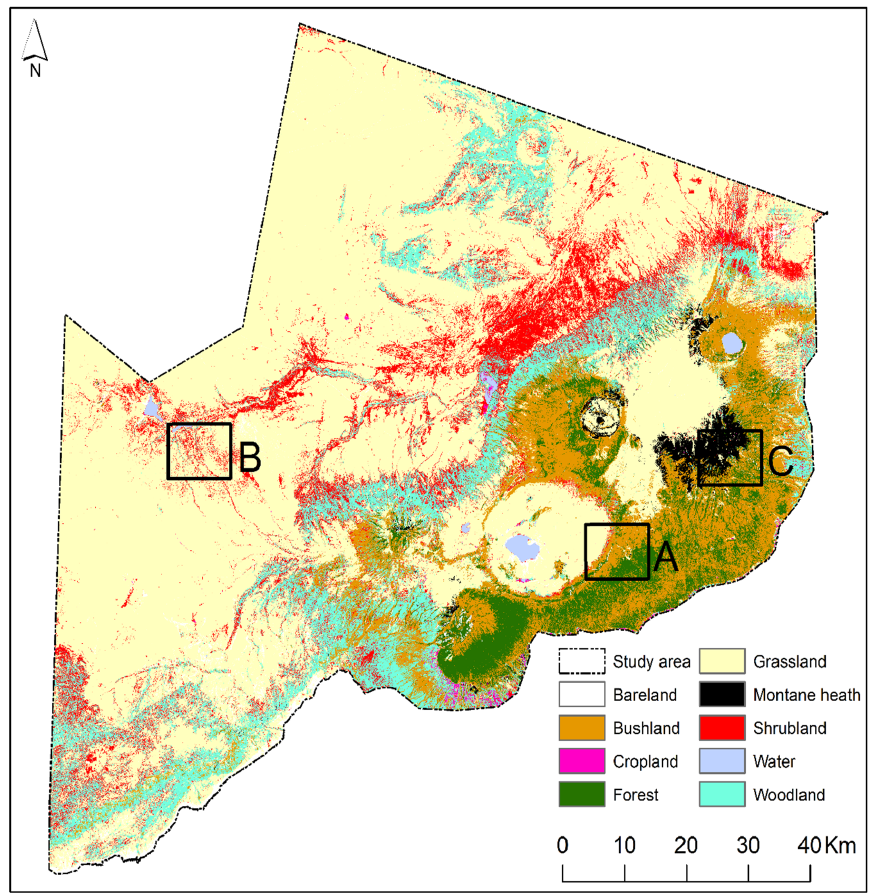
Figure 3. Output of the best performing model incorporating Sentinel-1 and Sentinel-2 data for both the dry and the short-dry season (i.e., Model 18). Locations A – C are the example subsets. that appear in the results.